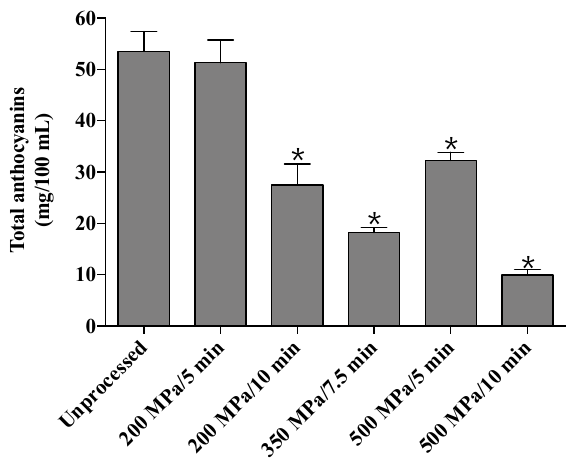
Figure 2. Total anthocyanins content (mg/100 mL) in unprocessed and HHP-processed jussara juices. Asterisks indicate significant differences from the unprocessed juice (one-way ANOVA followed by Dunnett’s post hoc test, p < 0.05).